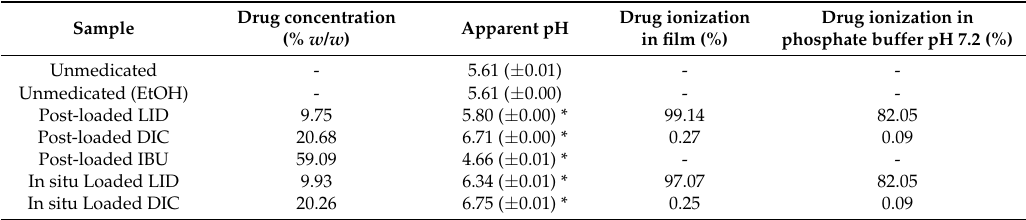
Table 7. Effect of loading method and drug physicochemical properties on the drug ionization. Values in brackets indicate the standard deviation from reported mean ( n = 3; * Significantly different from corresponding unmedicated hydrogels; p <